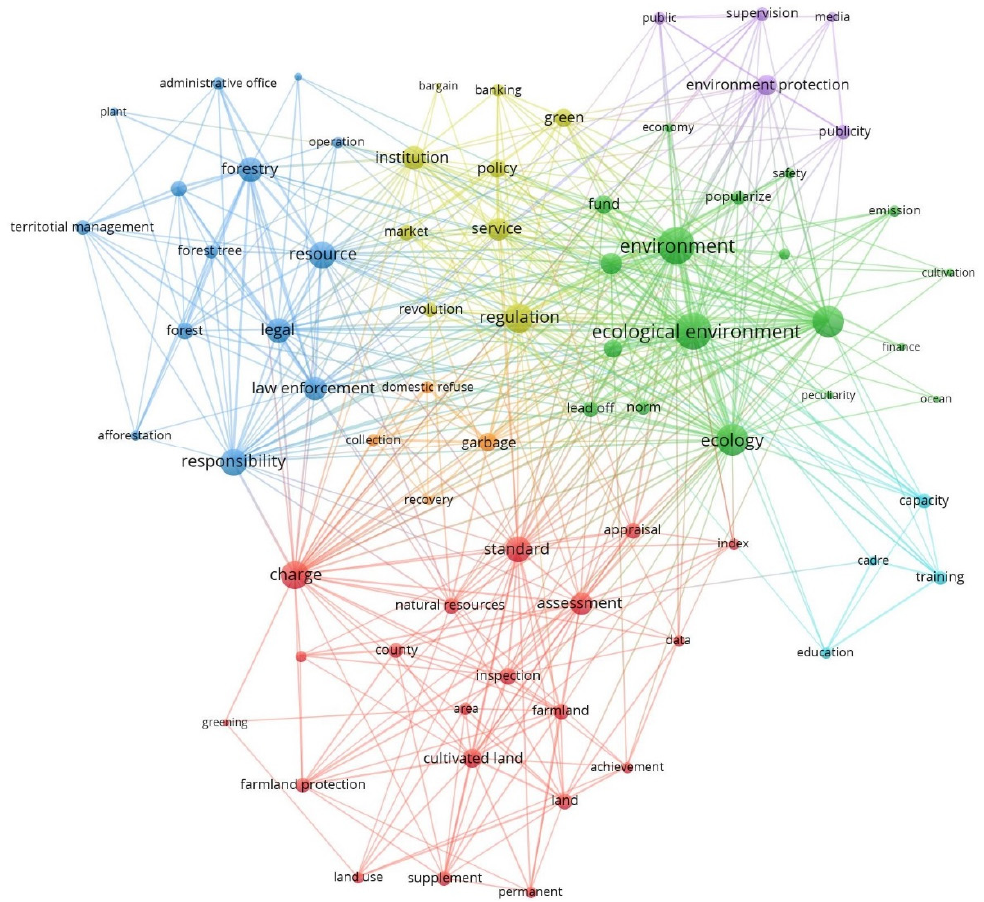
Figure 5. Co-word analysis and cluster analysis of keywords (2018–2020).